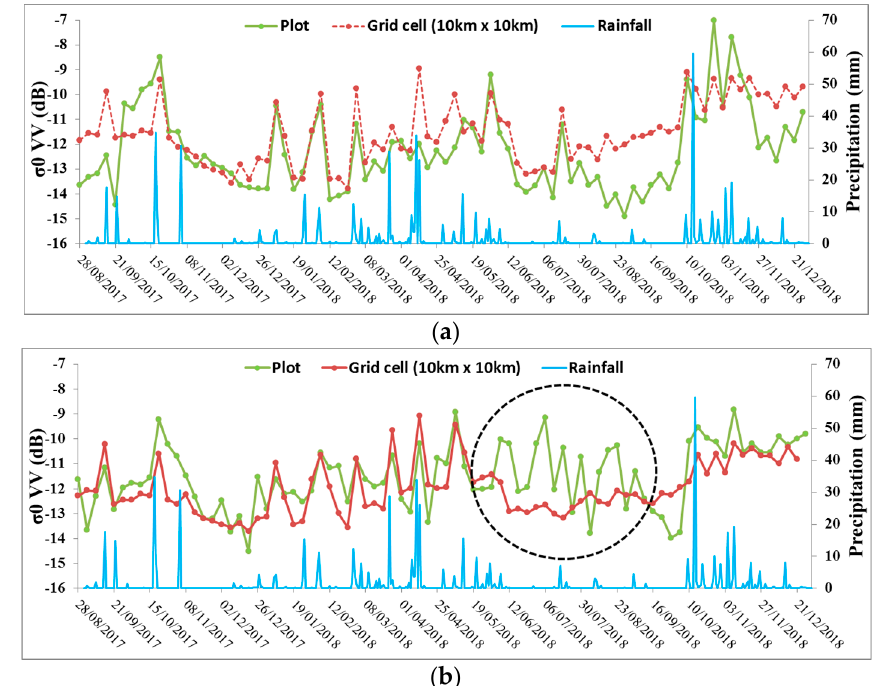
Figure 6. Temporal evolution of SAR backscattering coefficient σ ° in VV polarization at plot scale (green curve) and 10 km grid scale (red curve) with precipitation data recorded at a local meteorological station for ( a ) the non-irrigated plot, ( b ) the irrigated plot.